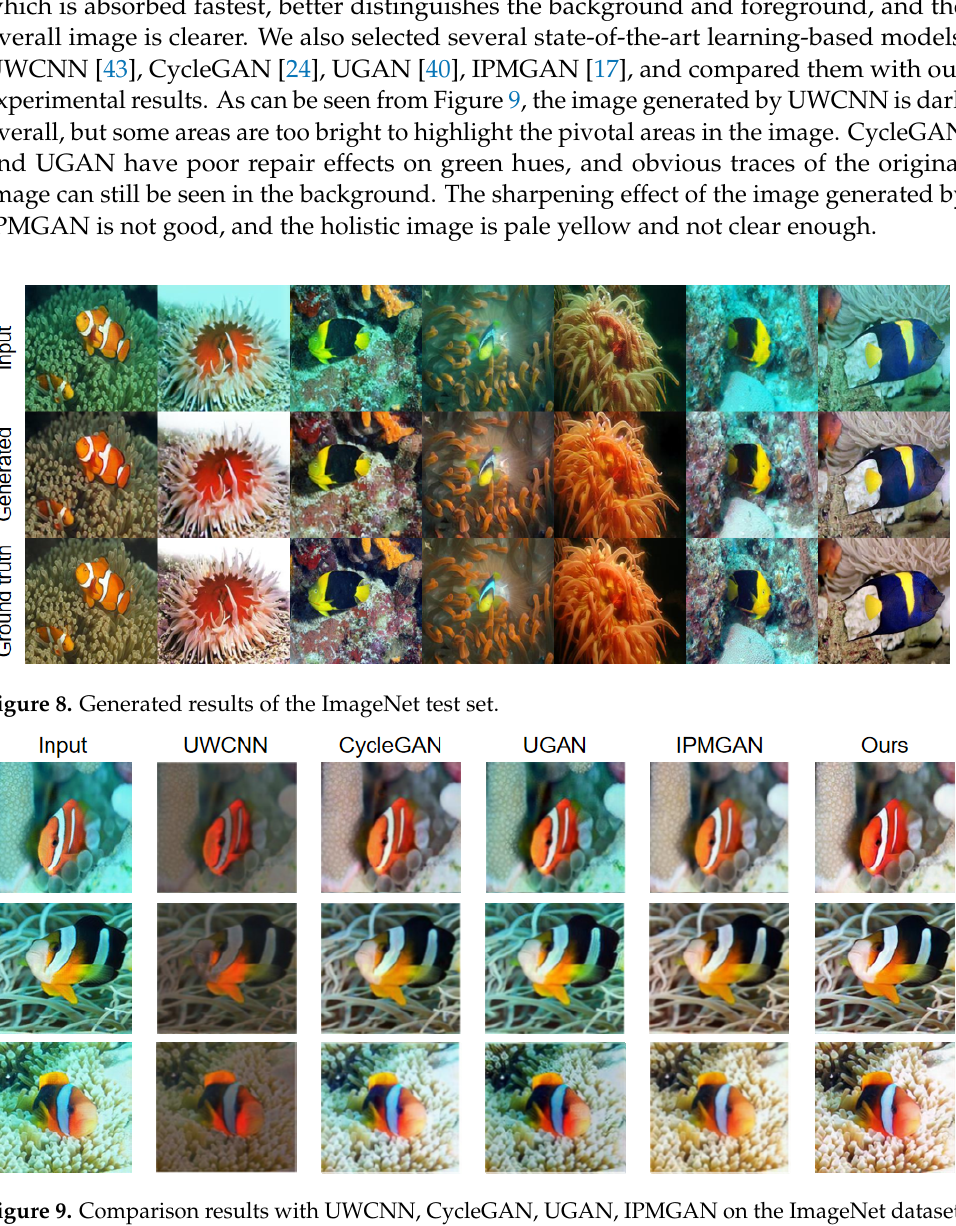
Figure 9. Comparison results with UWCNN, CycleGAN, UGAN, IPMGAN on the ImageNet